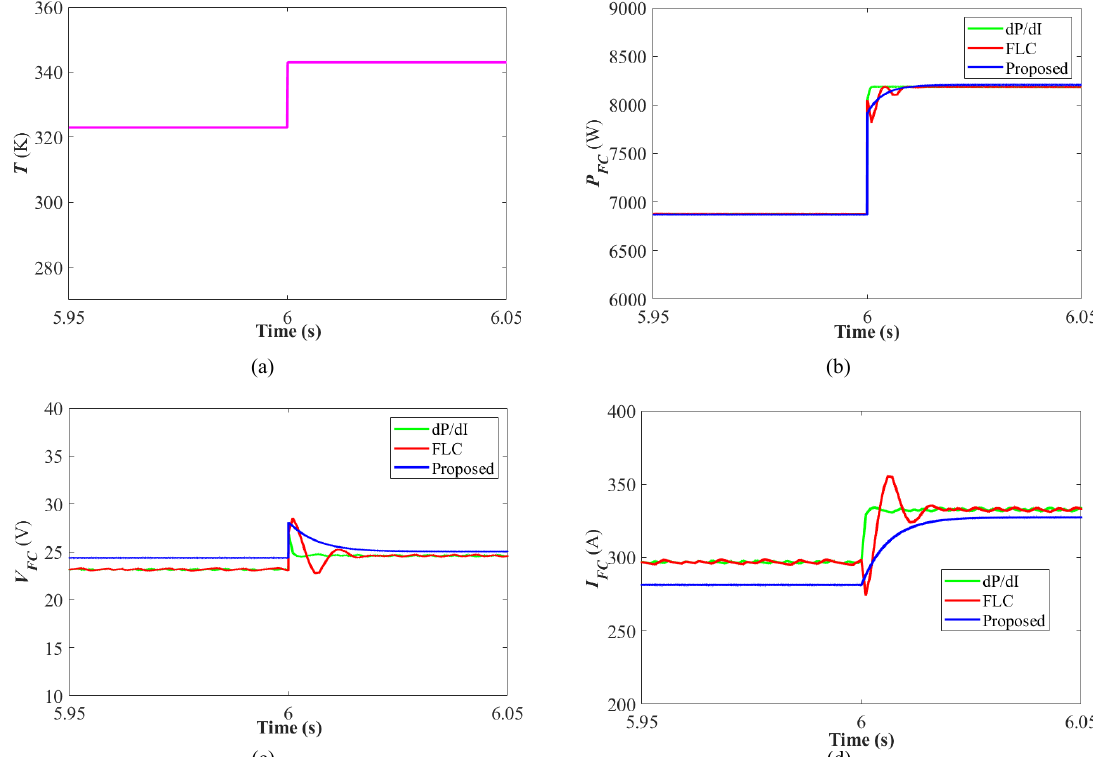
Figure 16. Results and comparisons at scenario 4: ( a ) T ; ( b ) P FC ; ( c ) V FC ; ( d ) I FC